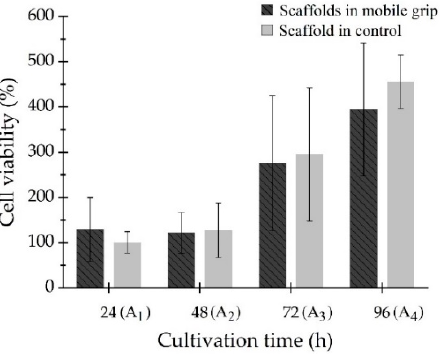
Figure 7. Viability of cells seeded on the collagen ‐ coated PCL scaffolds.